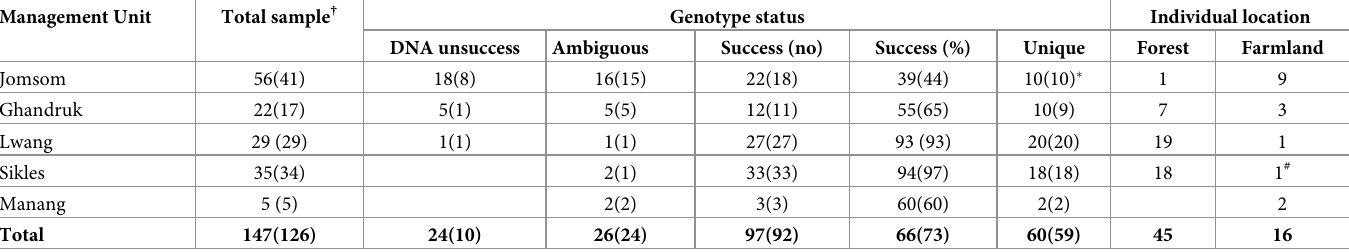
Table 1. Details of non-invasive sample size, genotyping success and the number of individuals located in forest vs. farmland in each management unit. Management